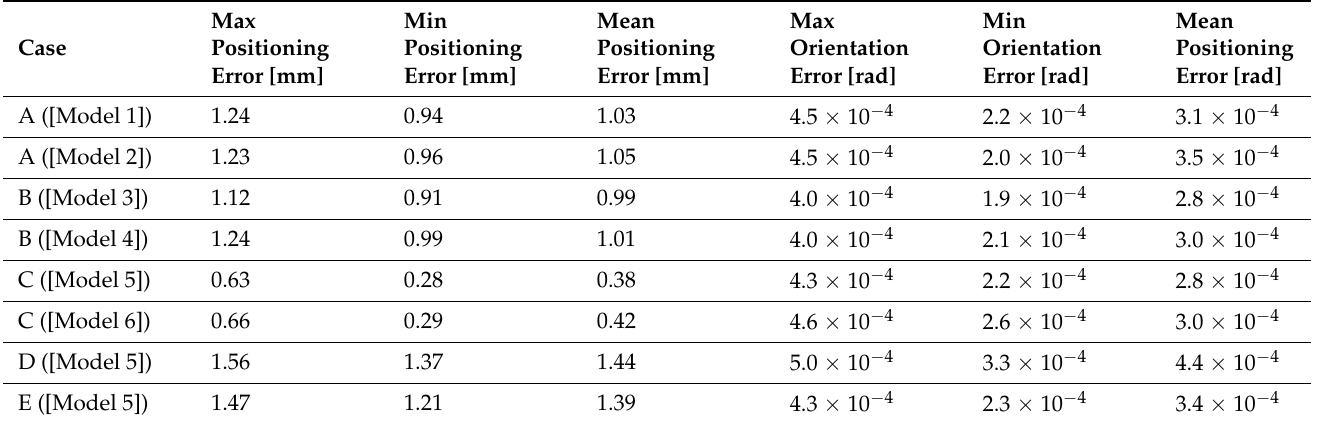
Table 4. Results of co-simulation in terms of end-effector accuracy: min, max, standard deviation, and mean values for the error recorded on the tested 24